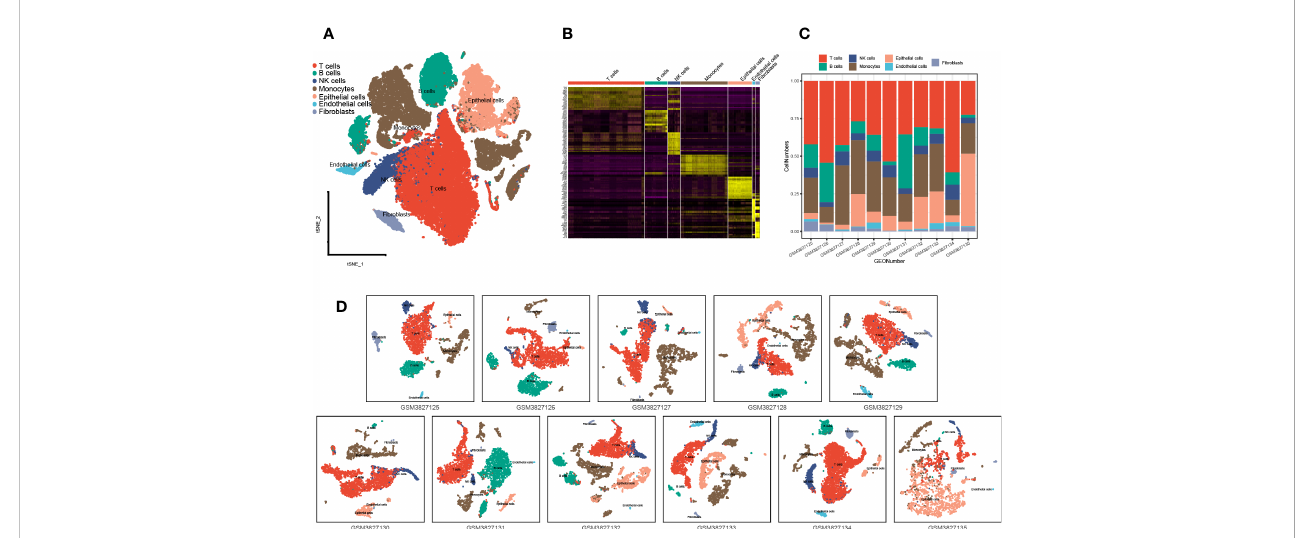
FIGURE 5 Single-cell analysis and cell type identi fi cation for 11 lung adenocarcinoma patient samples. (A) Seven main cell types of all 11 samples were integrated in one Seurat project and visualized in t-SNE plot. (B) The top 10 marker genes of different cell types were visualized in the heatmap. (C) Cell type proportions in different patient samples. (D) Seven main types of cells in different patient samples were visualized in the t-SNE plot. t-SNE: t-Distributed Stochastic Neighbor Embedding.